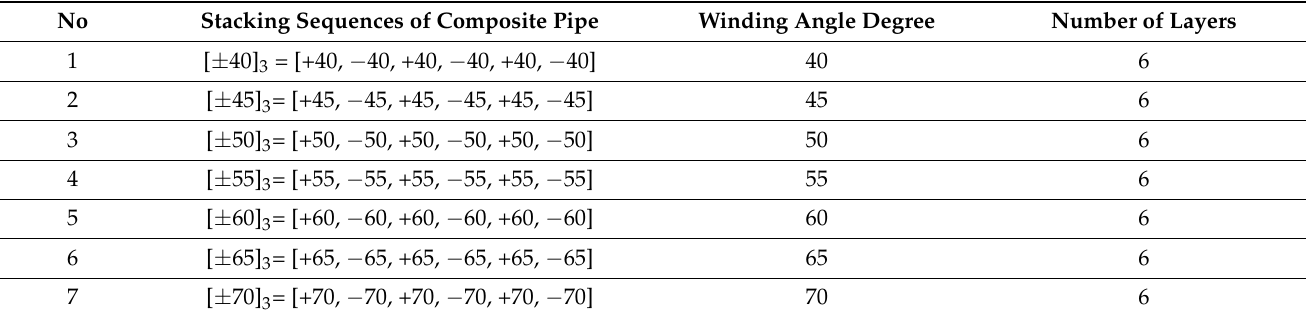
Table 4. Stacking sequences of GFRP composite pipes being